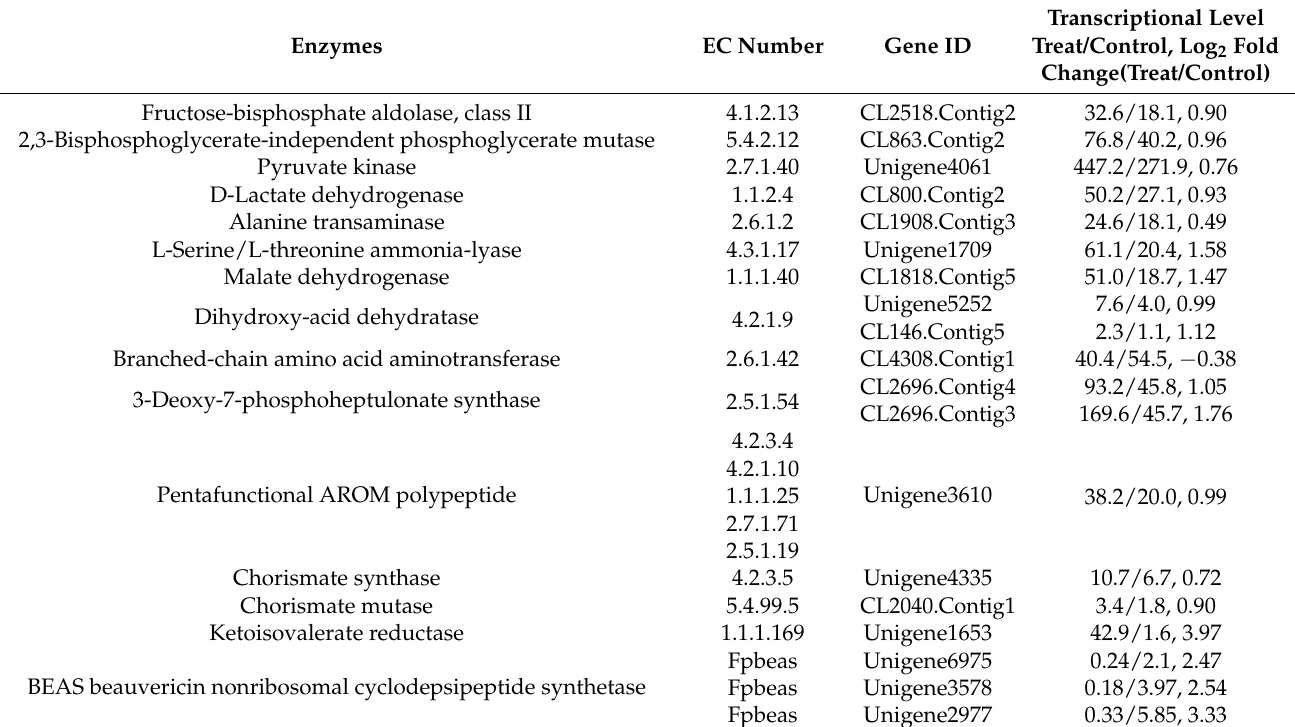
Table 2. Genes involved in BEA metabolism